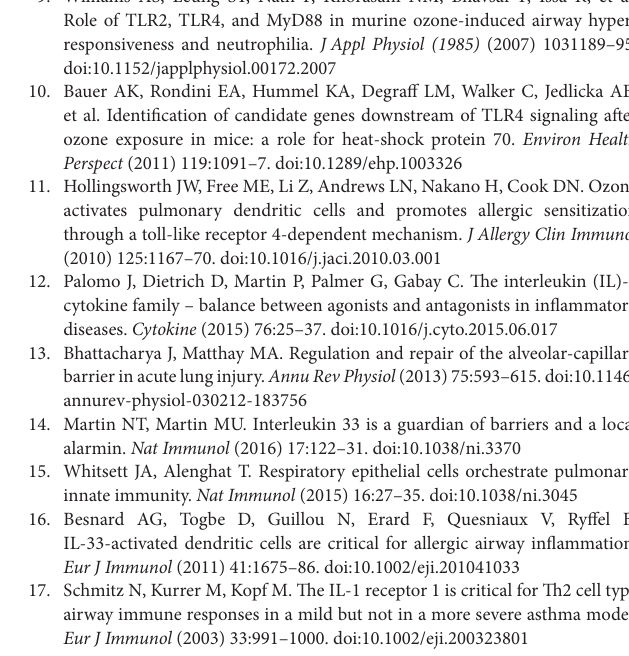
FigUre s1 | Gating strategy, epithelial cells desquamation, and interleukin-1 (IL-1) α and IL-1R α protein expression. Gatting strategy for epithelial desquamation analysis and cells mortality (a) . Epithelial cells desquamation after ozone exposure in wild type and IL-1 α − / − mice (B) . Analysis of IL-1 α and IL-1R α protein at 24 h after ozone exposure (c) . Representative data of two-independent experiments are shown. Results are expressed as mean ± SEM and are from one experiment, with n = 5–6. Statistical test: ordinary one-way ANOVA, with Bonferroni post test, p value: **** < 0.0001, *** < 0.001, ** < 0.01, * < 0.05. FigUre s2 | Cell mortality after ozone exposure. Gating strategy for cell death (a) . Cell death difference between air and ozone wild type (WT) mice (B) , epithelial cells mortality between WT, myeloid differentiation factor-88 (MyD88) − / − , MyD88 acid , and interleukin-1 α − / − mice after ozone exposure (c) . Representative data of two-independent experiments are shown. Results are expressed as mean ± SEM and are from one experiment, with n = 5–6. Statistical test: ordinary one-way ANOVA, with Bonferroni post test, p value: **** < 0.0001, *** < 0.001, ** < 0.01, * <